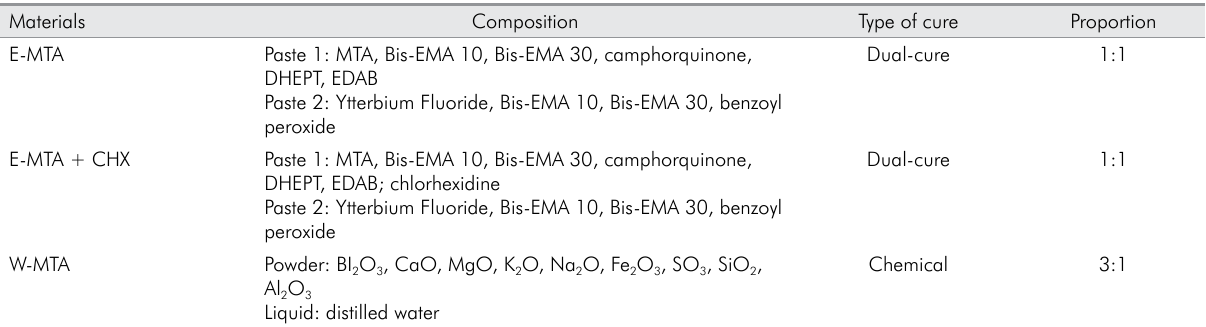
Table 1. Composition of materials used in the study. Materials Composition Type of